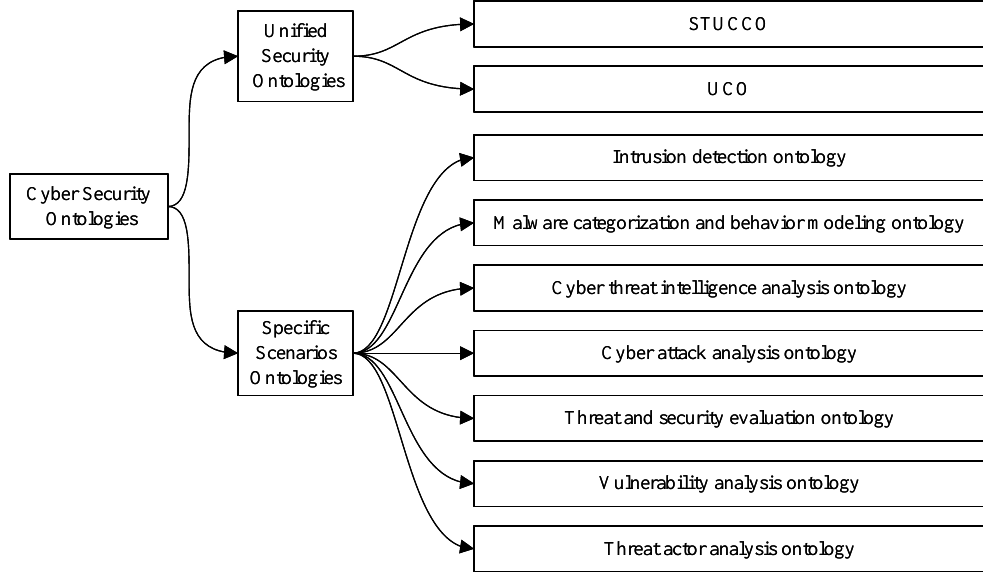
Figure 2. Cybersecurity ontologies.